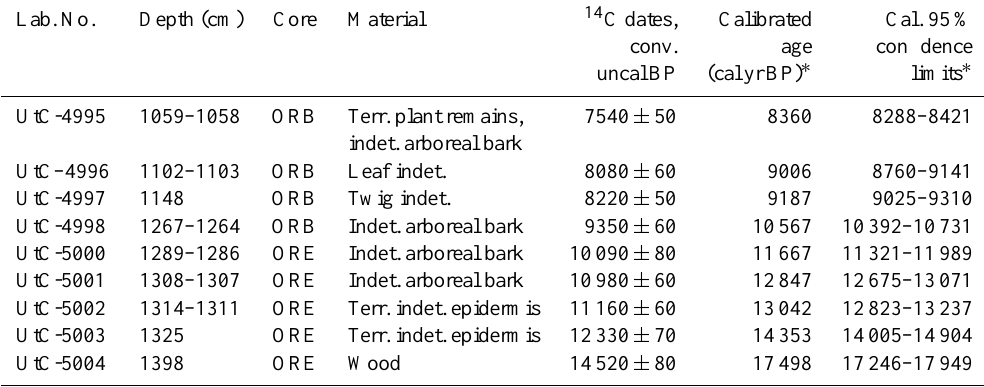
Table 1. 14 C dates of Origlio (ORE). Lab. No. Depth (cm) Core Material 14 C dates, Calibrated Cal. 95% conv. age confidence uncalBP (calyrBP) ∗ limits ∗ ORB Terr. plant remains, 7540 ± 50 8360 indet. arboreal